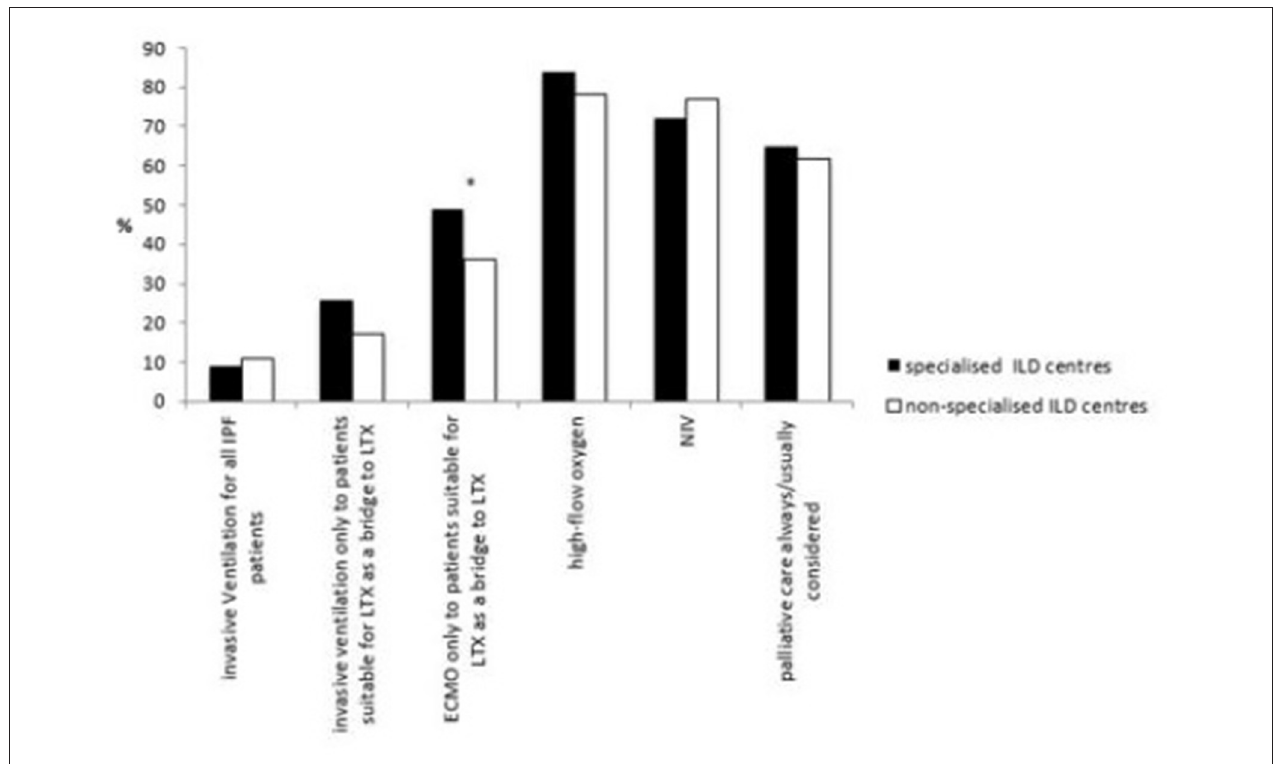
FIGURE 5 | Different management strategies in critically ill patients with AE-IPF in specialised and non-specialised ILD centres. Statistically significant differences are labelled with a * (p-value = < 0.05).